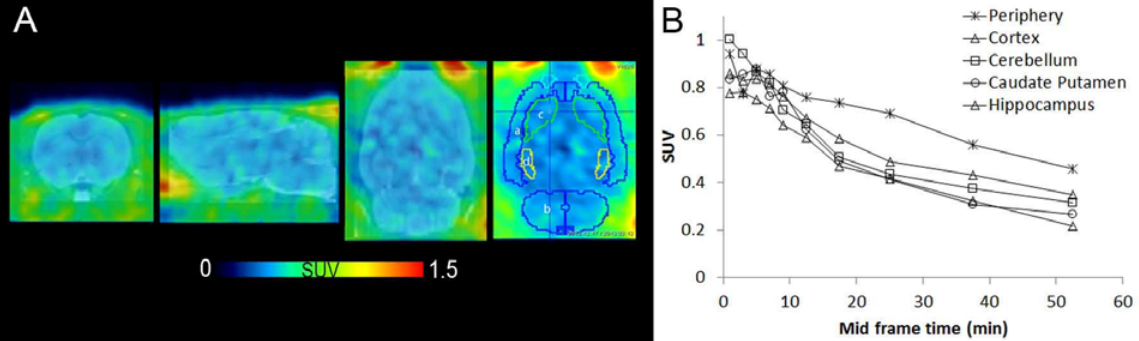
Figure 4. [ 11 C]KP23 PET images of a rat brain superimposed on an MRI template . A: From left, axial, sagittal and coronal sections. In the last coronal image, regions of interest are encircled and used for TAC analysis shown in B. a, cortex; b, cerebellum; c, caudate putamen; d, hippocampus. Images are averaged from 2–60 min p.i. B TACs of rat brain regions of [ 11